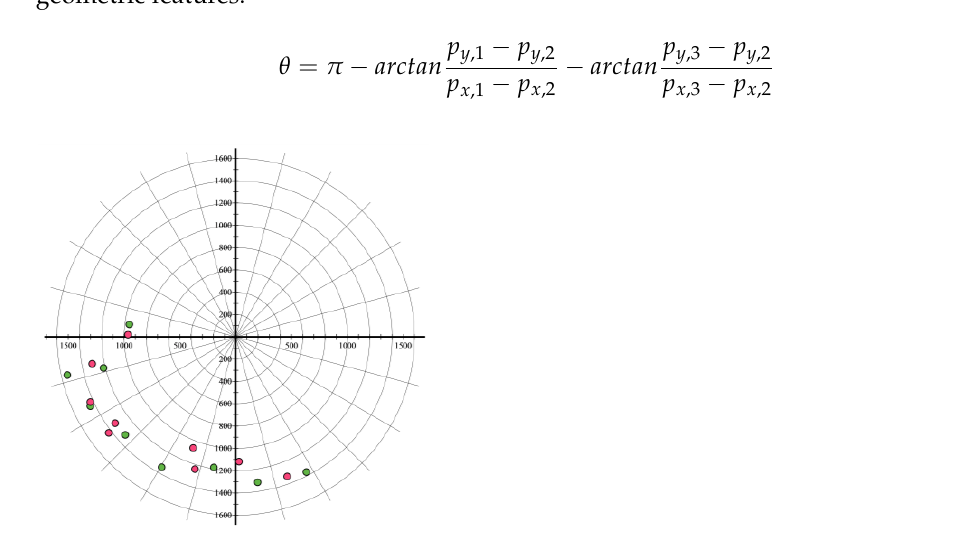
Figure 4. Feature point sets of curve P and curve Q